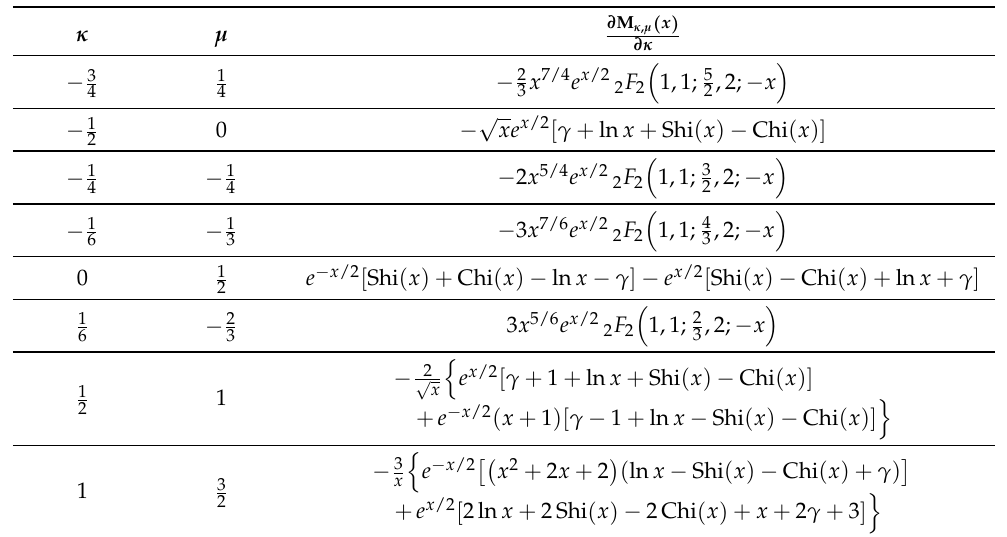
Table 1. Derivative of M κ , µ with respect to κ using